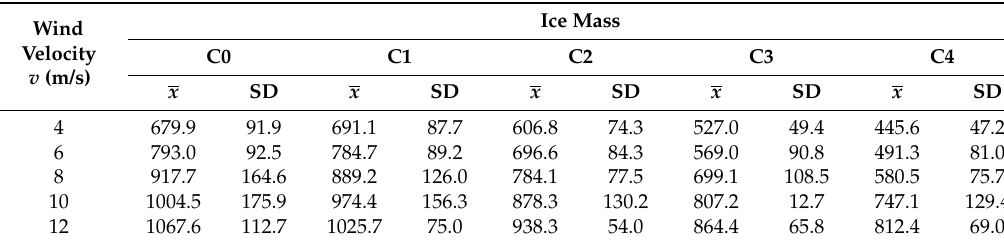
Figure 5. Ice mass of blade samples under Conditions 3, 6, and 7. Table 3. The ice mass of C0–C5 under Conditions 1–5.